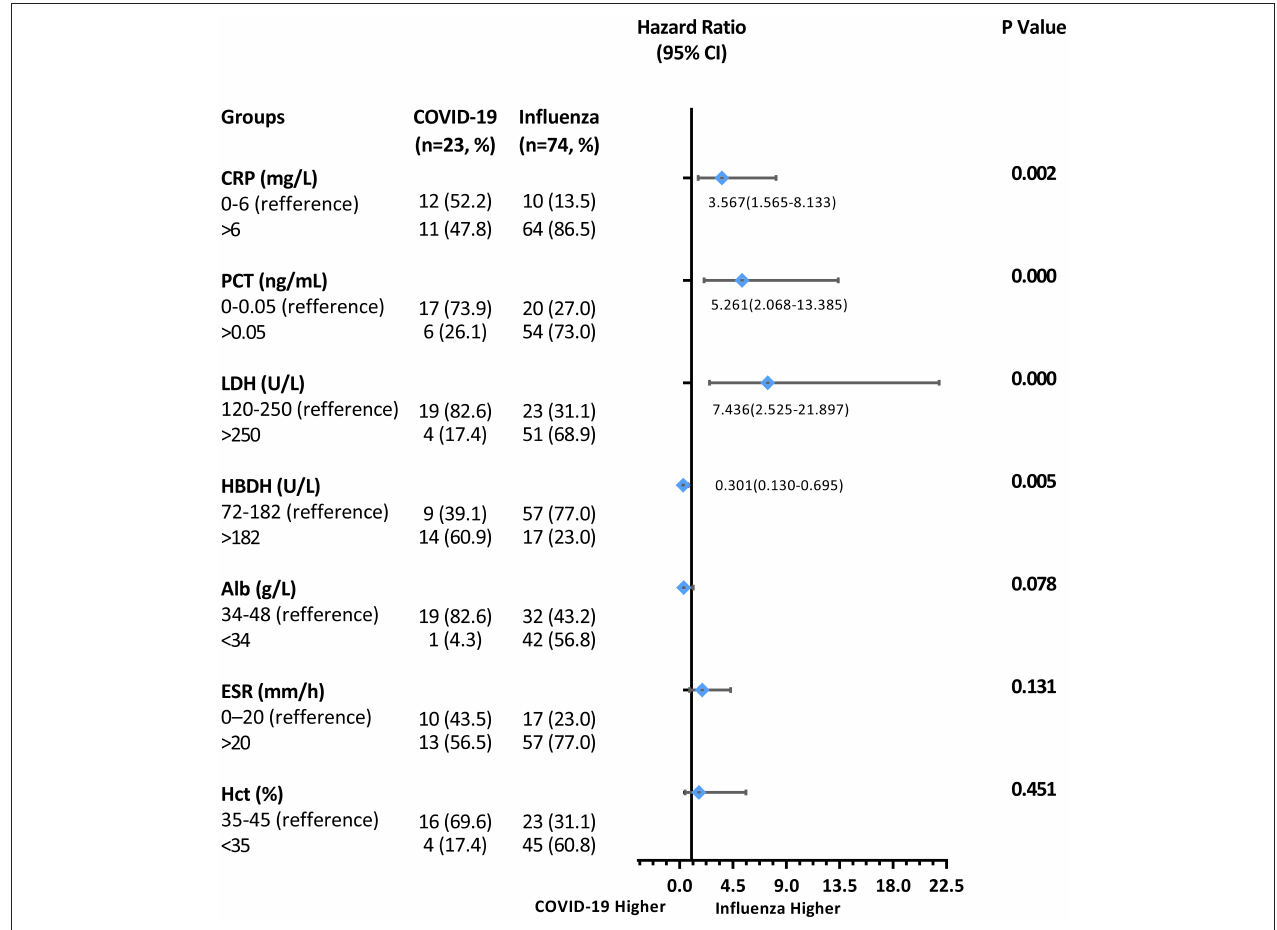
FIGURE 4 | Multivariate analysis for differentiating COVID-19 from influenza patients.